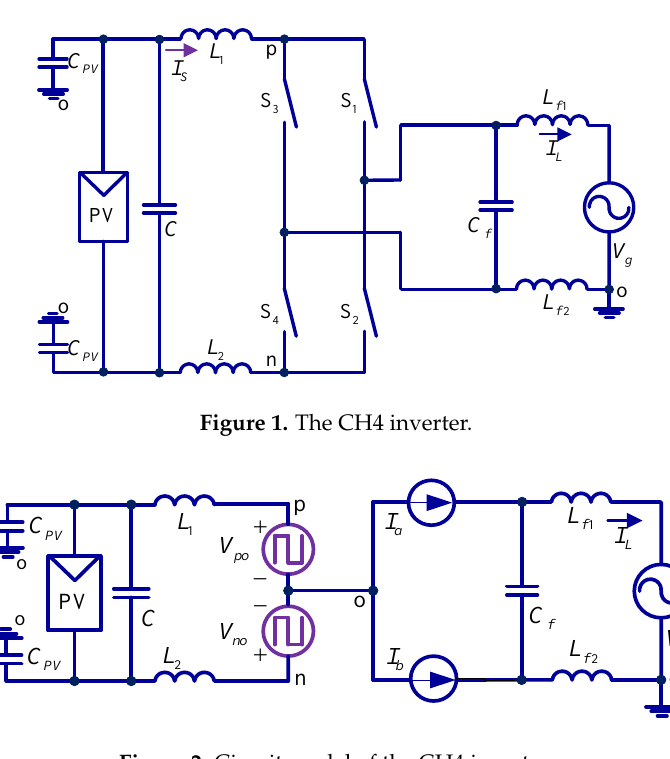
Figure 2. Circuit model of the CH4 inverter.